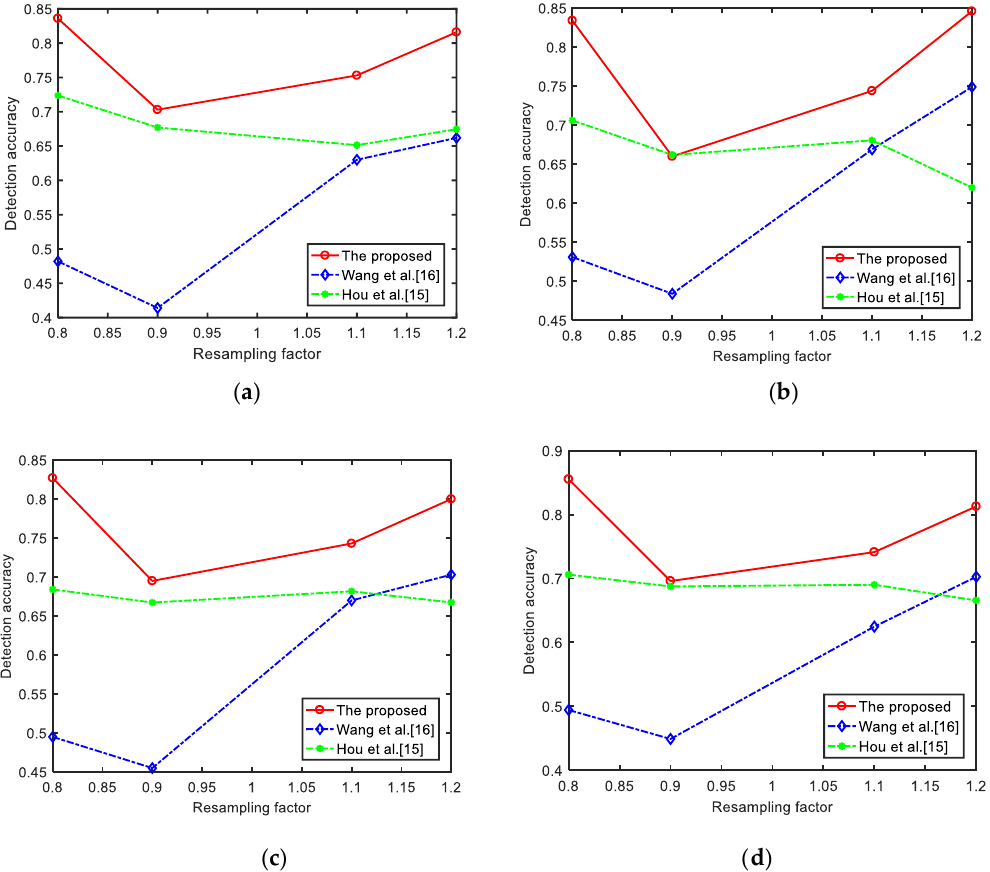
Figure 8. Influence of different interpolation conditions on resampling detection. ( a ) The detection accuracy in the case of linear interpolation; ( b ) the detection accuracy in the case of spline interpolation; ( c ) the detection accuracy in the case of cubic interpolation; ( d ) the detection accuracy in the case of mixed interpolation.